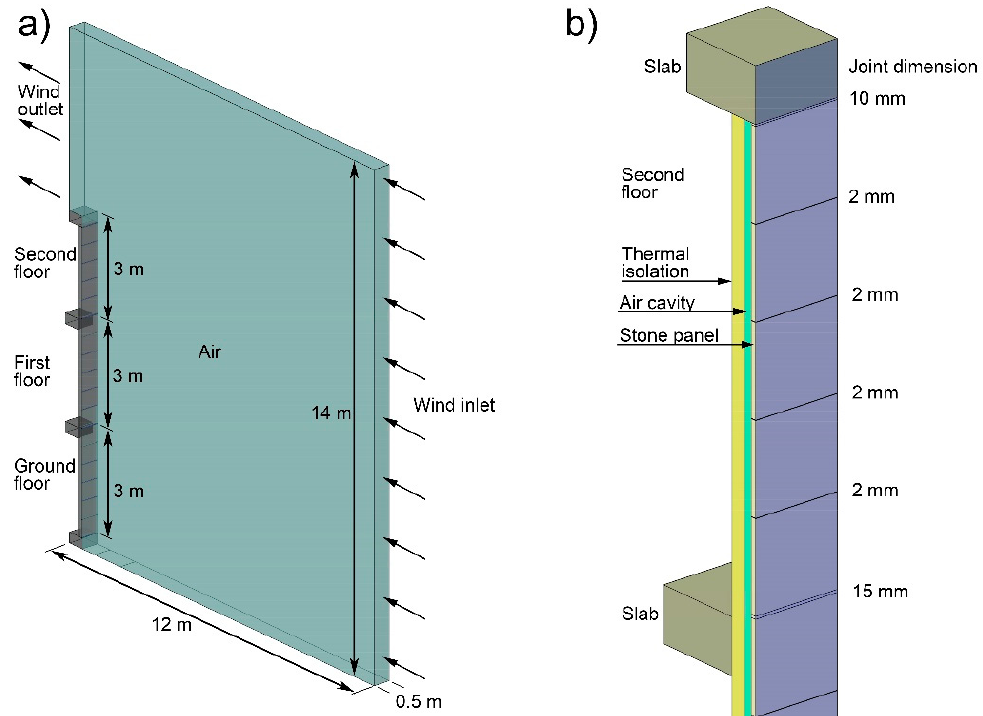
Figure 1. Geometry of the models used in the simulations: ( a ) General view and ( b ) detail view. The overall volume is 12 × 14 × 0.5 m 3 . The distance between the slabs of the building is 3 m. This volume allows the air to have a certain distance before reaching the enclosure; being only 0.5 m in width, the mesh does not have an inordinate number of elements to